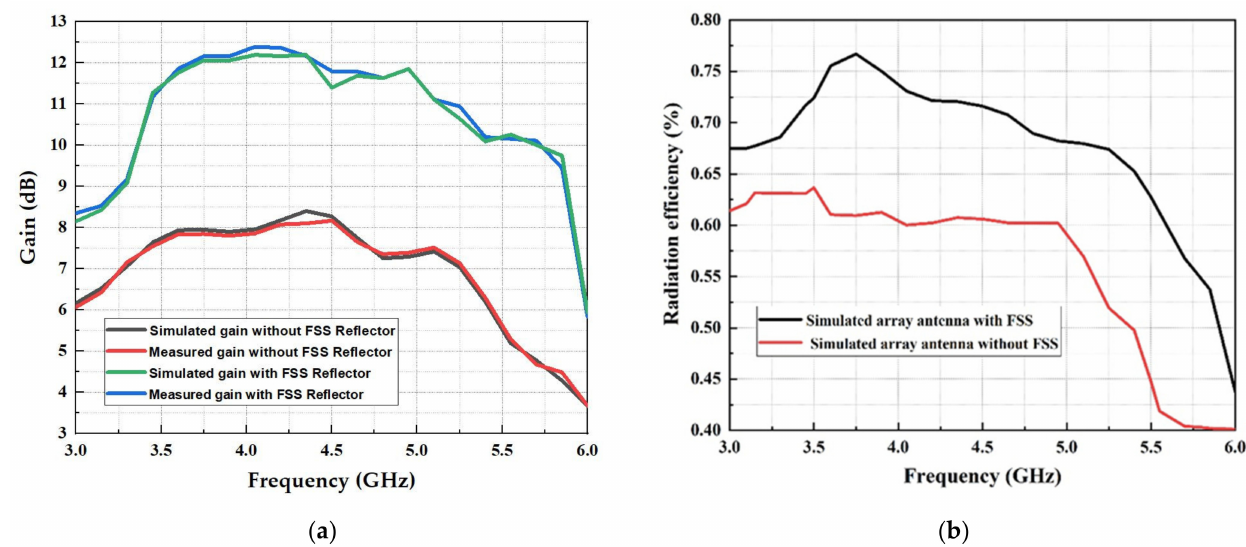
Figure 14. ( a ) Comparison of the simulated and measured gain of the wideband array antenna with and without the FSS reflector; ( b ) simulated efficiency of a wideband array antenna with and without the FSS